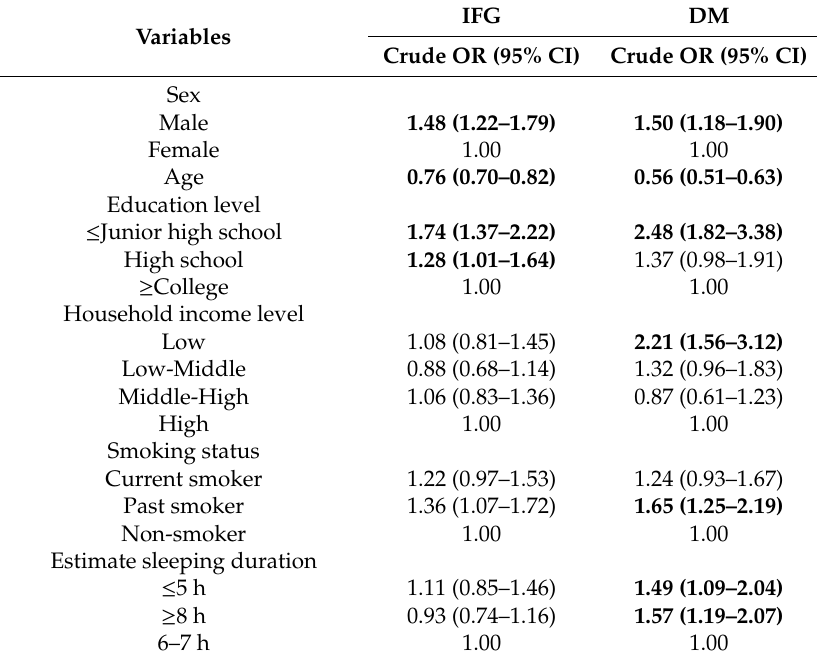
Table 3. The prevalence of fasting serum glucose disorder and diabetes with periodontitis.